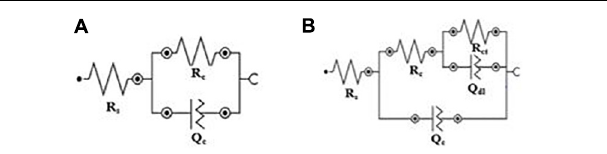
FIGURE 7 | Electrical circuits used for fitting the coatings electrical parameters. (A) One-time constant R s (Q c R c ) and (B) two-time constants R s {Q c [R c (Q dl R c )]}.